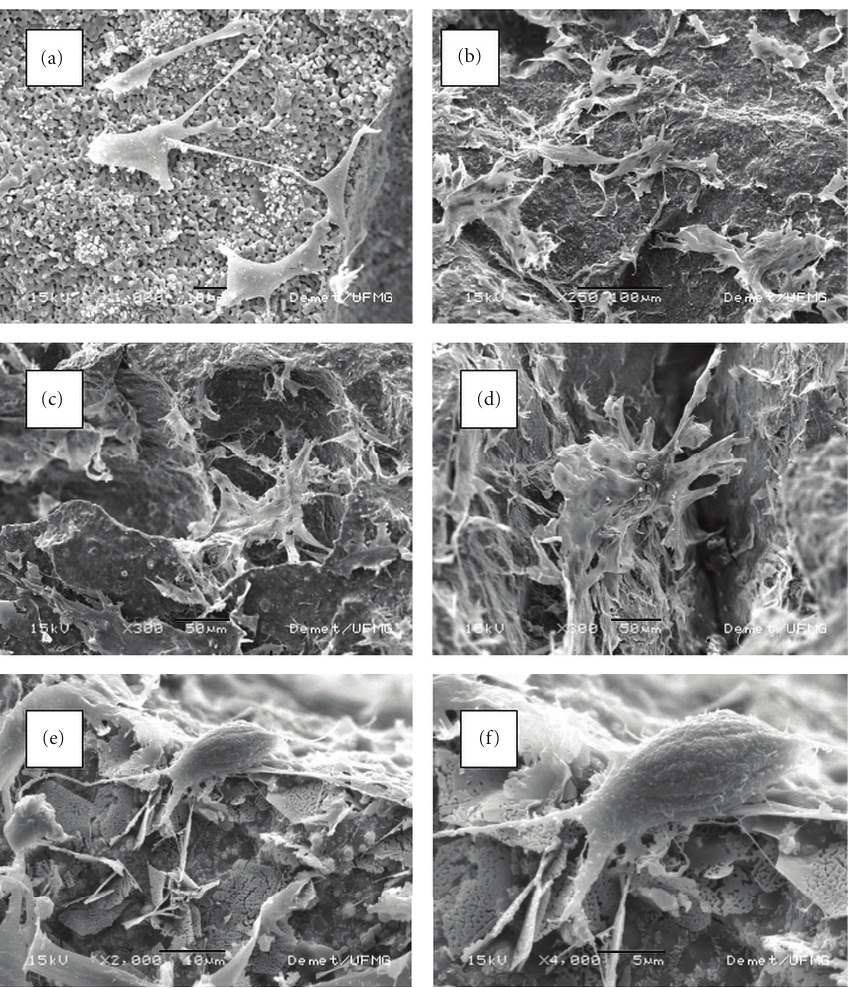
Figure 6: SEM micrographs of the morphology of osteoblast cultured on LiHA matrix for 120 hours. Images demonstrated osteoblast adhesion to the matrix surface and interaction between cells. (a) Scale bar: 10 μ m, (b) scale bar: 100 μ m, (c-d) scale bar: 50 μ m, (e) scale bar: 10 μ m, and (f) scale bar: 5 μ m.